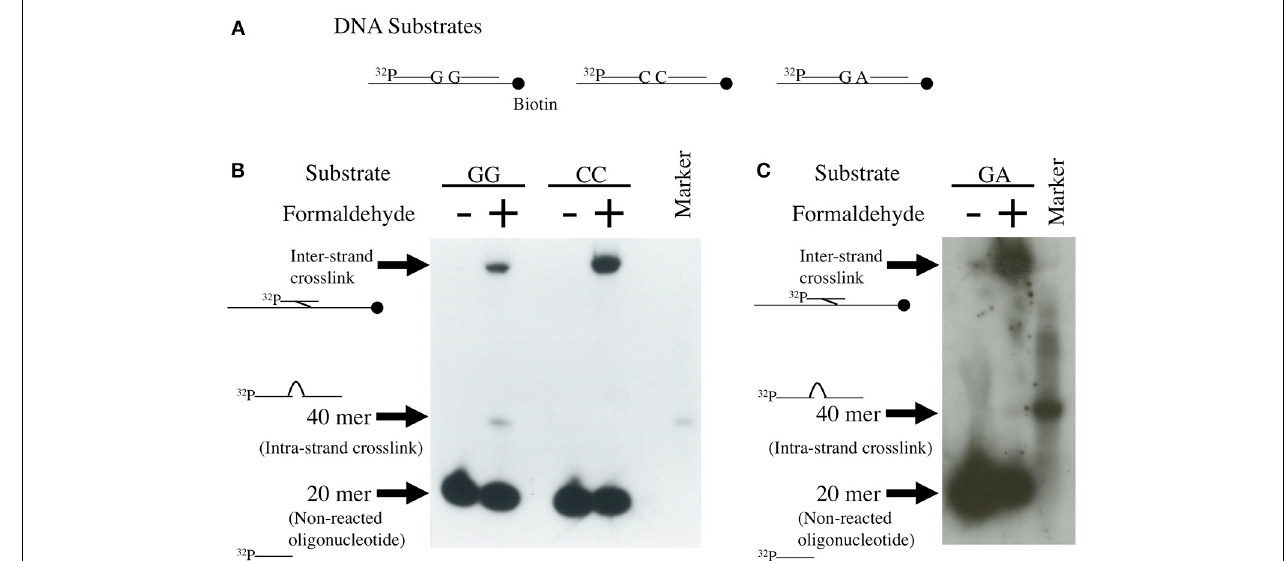
unlabeled 20-mer complementary DNA, the sequence of which followed the 3 (cid:2) -end of the 32 P-labeled 20-mer DNA and had G, A, T, or C at the 5 (cid:2) -end, were also prepared. The biotinylated 175-mer DNA, [ 32 P]-labeled complementary 20-mer DNA and the following non-labeled complementary 20-mer DNA were annealed by heating and cooling for detecting GG, CC, and GA-intrastrand crosslinks, as shown in (A) . The annealed DNA was treated with 270mM formaldehyde for 24h at 4 ◦ C. After collecting DNA using a magnet, DNA was purified and subjected to electrophoresis on denatured polyacrylamide gel. Autoradiography images of the gel are shown in (B,C)